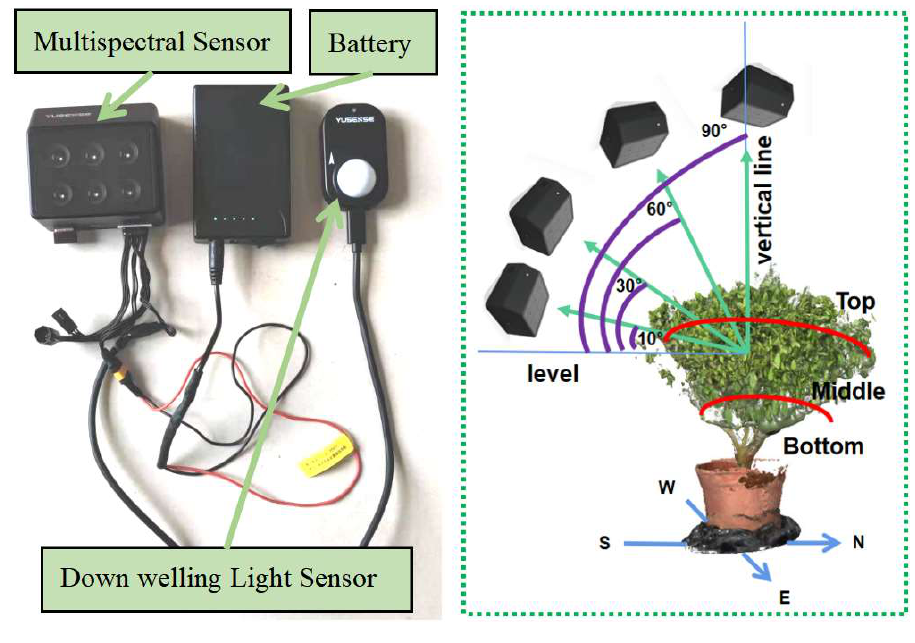
Figure 4. The top section sample included the 3rd to 5th leaves from the top of the branch, downwards; the middle section included the 6th to 10th leaves; and the bottom section included the 1st to 5th leaves from the bottom of the branch, upwards. Each leaf was measured thrice from the leaf tip, petiole end, and middle, avoiding the leaf vein. The mean of the value measured by spad-502 plus (Konica Minolta Holdings Co., Ltd., Tokyo, Japan) was considered the SPAD of the leaf. After measurement, the leaves were oven- dried together with other samples and transferred to the laboratory at a third-party pro- fessional testing company (Xi’an Guolian Quality Testing Technology Co., Ltd., Xi’an, China) to analyse the total chlorophyll and nitrogen contents. For the convenience of de- scription, the SPAD, total chlorophyll content, and nitrogen content of the assay were col- lectively referred to as the physiological parameters of the tea.